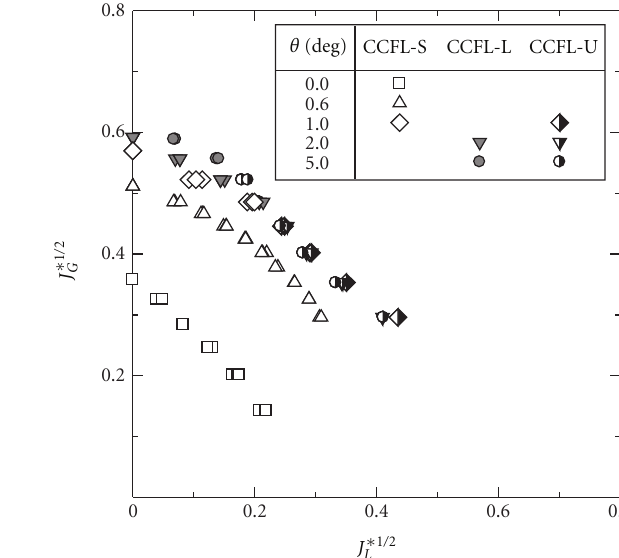
Figure 6: CCFL characteristics ( θ = 0 . 6 deg.). Figure 7: CCFL characteristics (e ff ects of θ